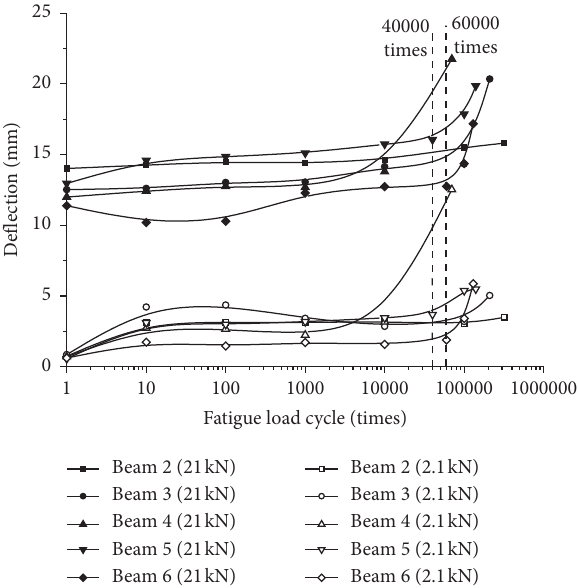
Figure 10: Deflection-fatigue load cycle curve of each tested